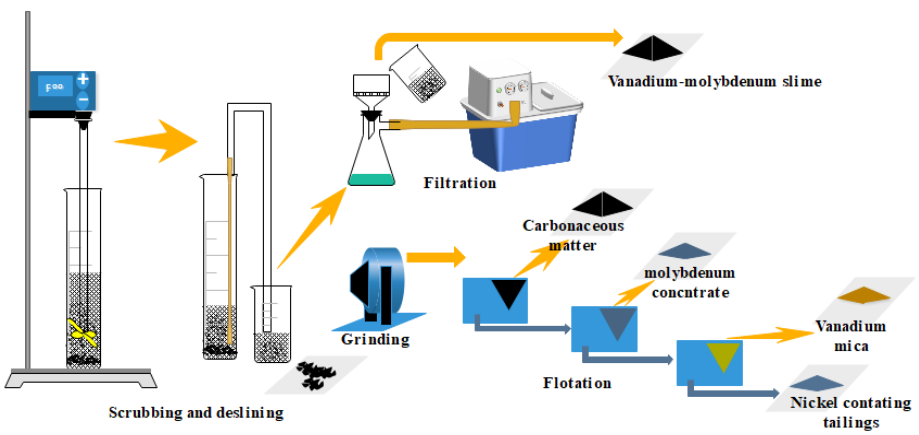
Figure 1. The experimental flow chart of scrubbing–desliming–flotation.